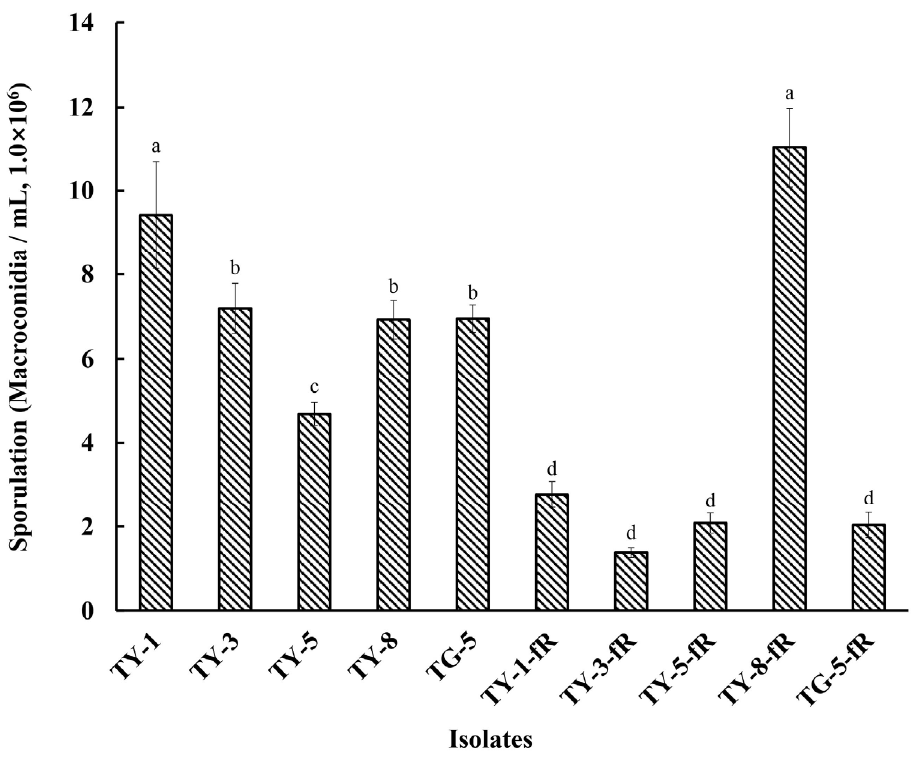
Figure 2. Sporulation of five fludioxonil-resistant mutants (TY-1-fR, TY-3-fR, TY-5-fR, TY-8-fR, and TG-5-fR) of FOM in comparison to their parental isolates (TY-1, TY-3, TY-5, TY-8, and TG-5). Data are the means of six replicates ± SE. Different letters above columns indicate significant differences according to Fisher’s least significant difference test ( p ≤